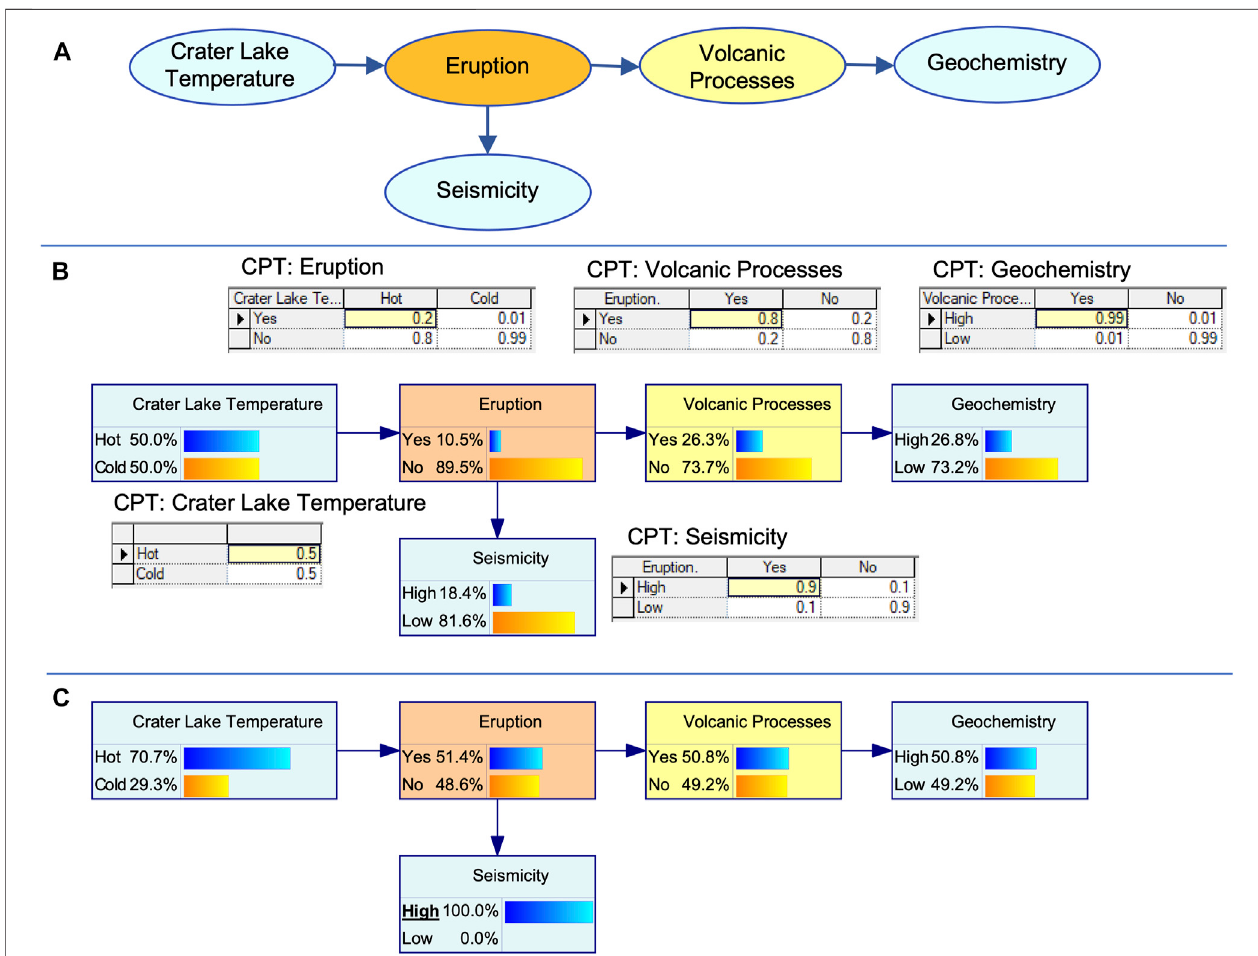
FIGURE1| Illustrationof (A) aBNstructure (B) ConditionalProbabilityTables(CPTs)associatedwitheachnode,and (C) inference,wheretheobservationof “ High Seismicity ” changestheprobabilitydistributionoftheothernotes.Monitoringdatashowninblue,theEruptionnodeinorangeand “ MagmaticIntrusion ” asahiddennode for avolcanicprocess inyellow.Thedirectionofthearrows connectingthenodesdo notindicate causation, or alinearprocess intime.Instead, theyre fl ectdependence that ismodelled with probabilistic relationships. Subplot (B) shows example of CPTs for a simpli fi ed model, where each variable has only two states. For all but the node Crater Lake Temperature, the distribution of the states is conditional on the states of the parent node. In the text we provide example calculations for the probabilities, as well as for the inference in (C) .